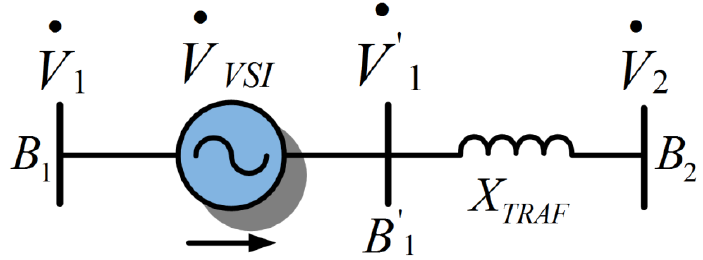
Figure 2. Simplified diagram of proposed methodology for regenerative tests.